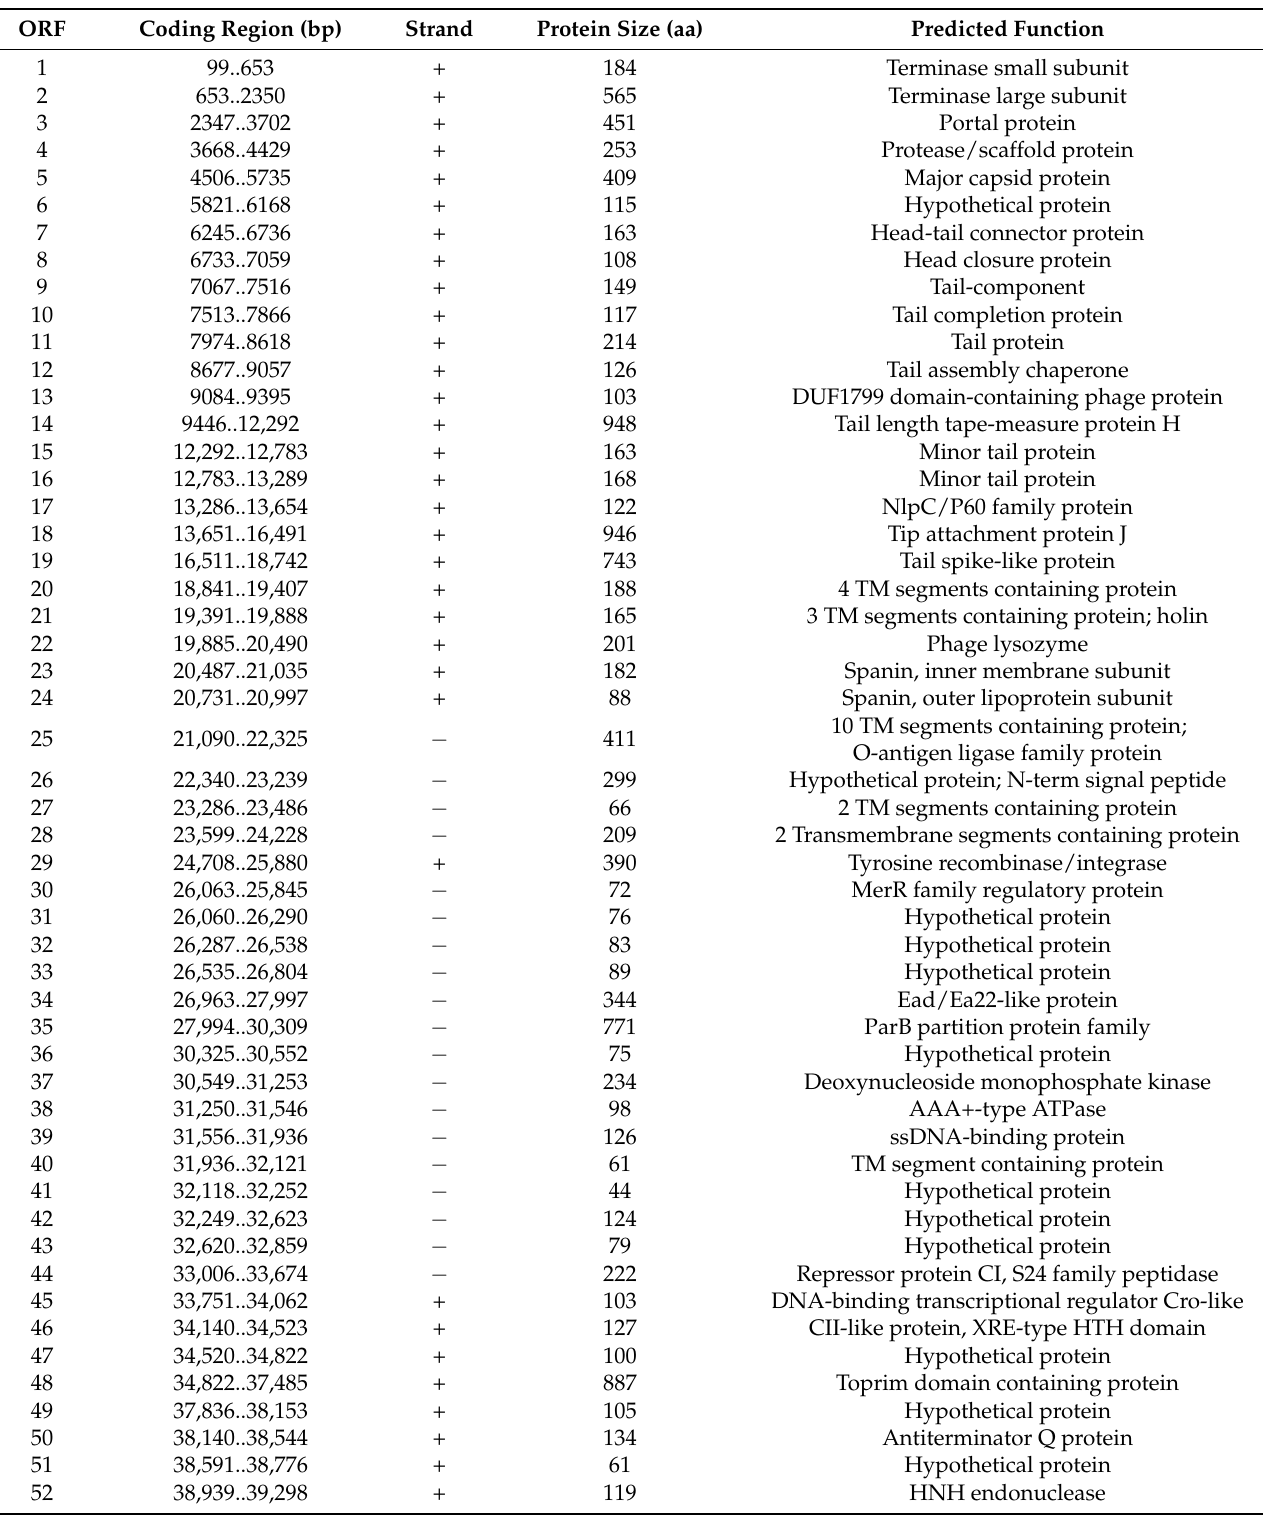
Table 1. Genes located within the VarioGold